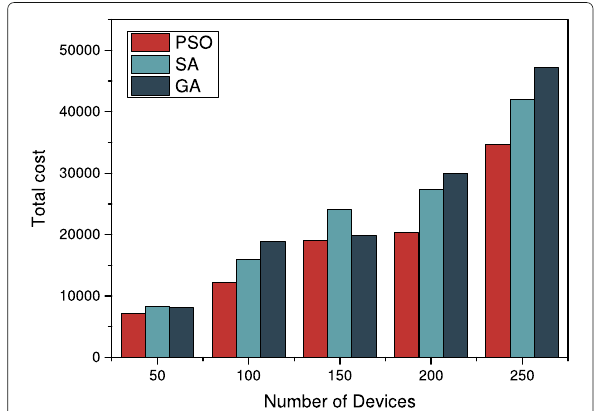
total delay is increasing, which is due to the increase in the number of devices, the required processing time and transmission time also increase. However, as the number of tasks increases, the increase in the total delay of PSO is less than the increase in the total delay of GA and SA. When the number of devices is less than 150, the results of GA and SA are not much different from that of PSO. When the number of devices is larger than 150, the total system cost of GA began to rise rapidly and is much higher than PSO. It can be observed from the figure that when the number of devices is 250, PSO is superior to SA and GA. The total cost of SA is 17.4% higher than that of